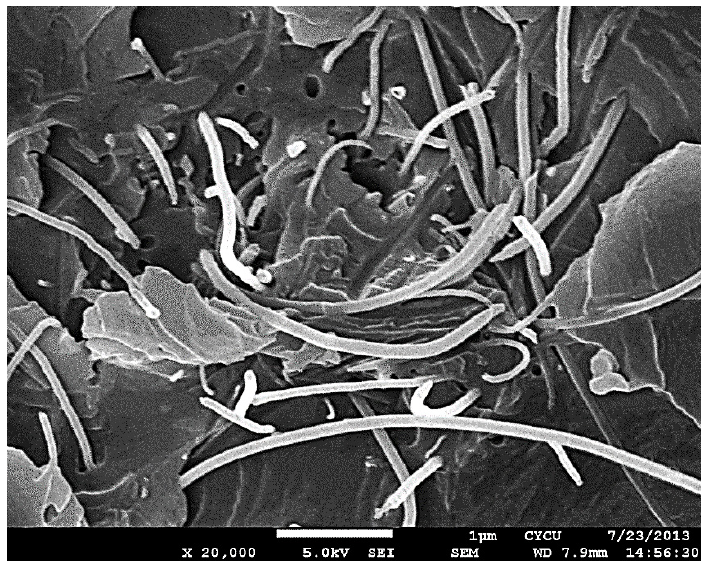
Figure 13. SEM image of the nanocomposite with 0.8 wt % of MWCNT.